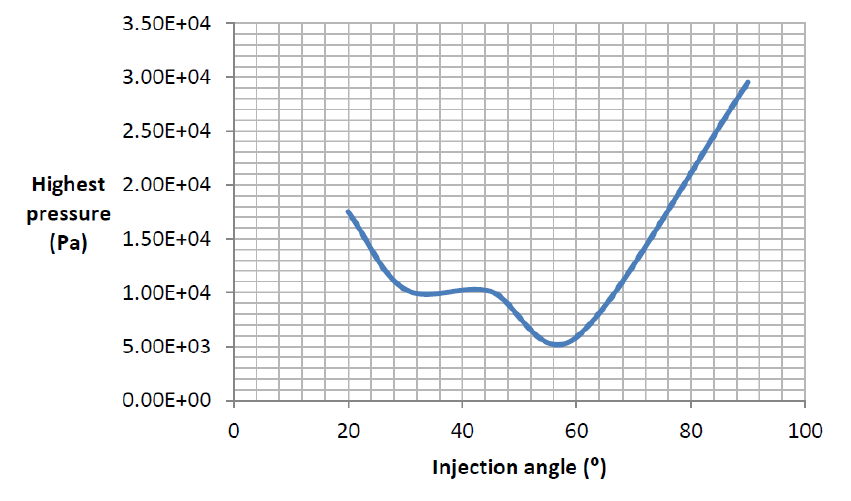
Figure 12: Highest pressure vs. injection angle curve for glass fibre resin, 35 ms −1 wind velocity, 0.3 mm diameter sand particle injection at 0.5 kgs −1 mass flow rate.